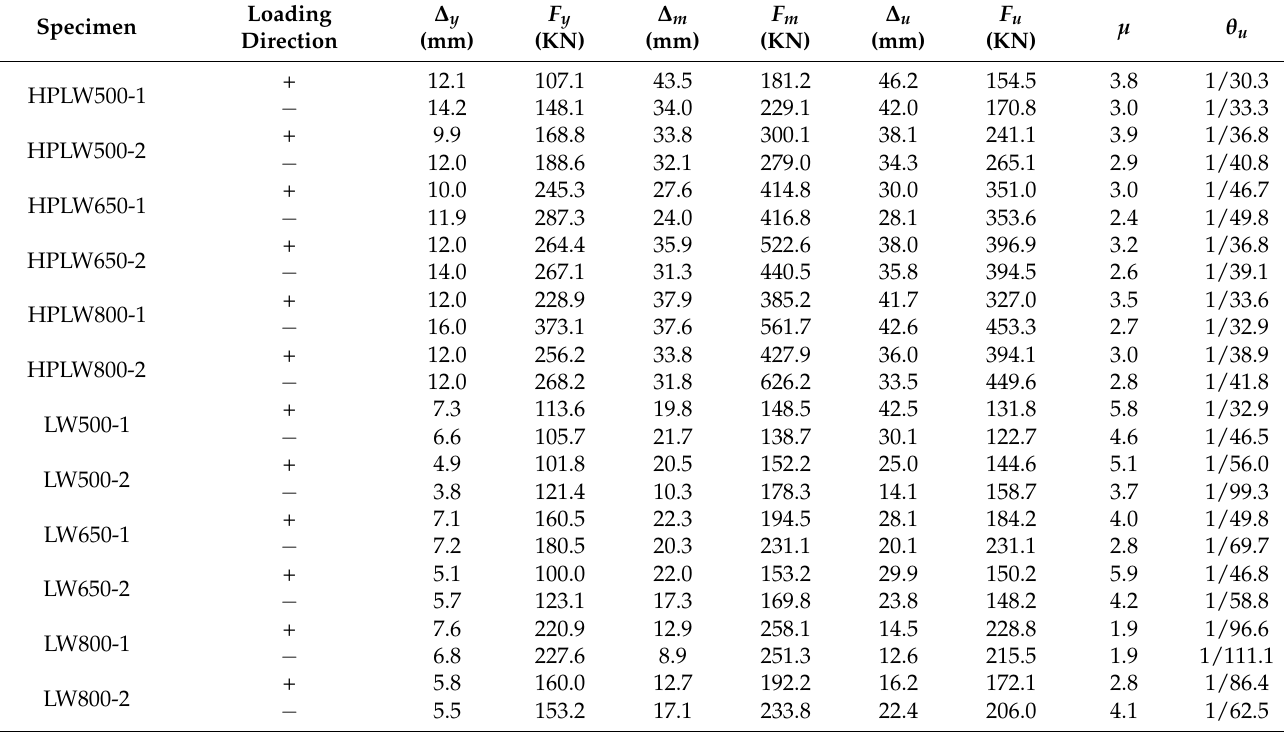
Table 3. Load-bearing capacity and displacement ductility of HPLW and